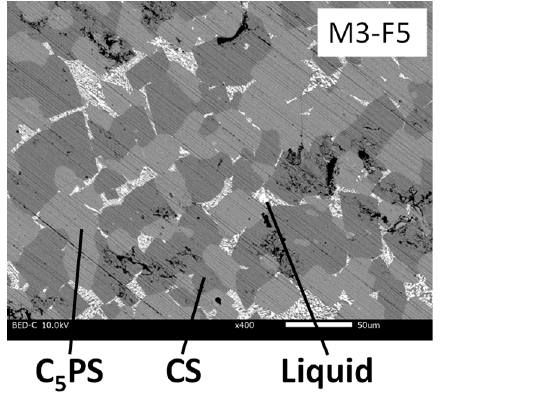
Figure 11. SEM image of M3-F10 (10mass% Fe 2 O 3 ) ( left ) and the phase composition projected on an isothermal section of the CaO-SiO 2 -P 2 O 5 ternary phase diagram at 1573 K ( right ). Table 5. Compositional analysis of the observed phases in the quaternary samples containing Fe 2 O 3 (in mass%). Sample No. Liq 1 Estimated phase. Liq—liquid phase. (Bulk composition) Eutectic composition in CS-C 3 P pseudo-binary (1693K) C 5 PSC 7 PS 2